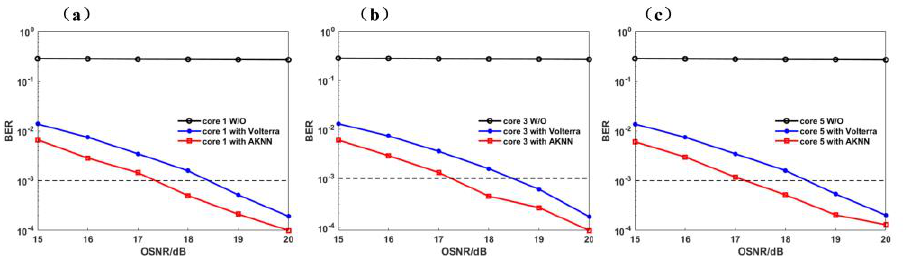
Fig. 5. (a) Relationship between BER and OSNR of core 1 equalized by AKNN algorithm; (b) Relationship between BER and OSNR of core 3 equalized by AKNN algorithm; (c) Relationship between BER and OSNR of core 5 equalized by AKNN algorithm